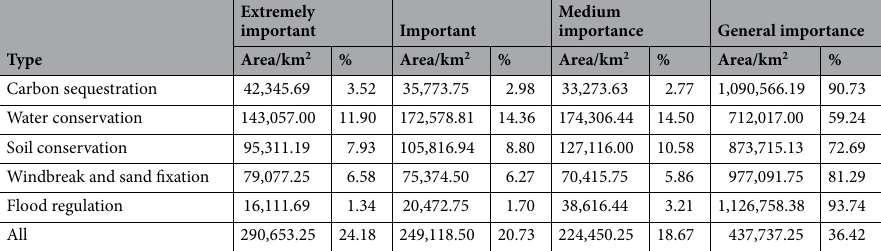
Table 2. Area and proportion with different levels of importance for ecosystem services in Tibet.